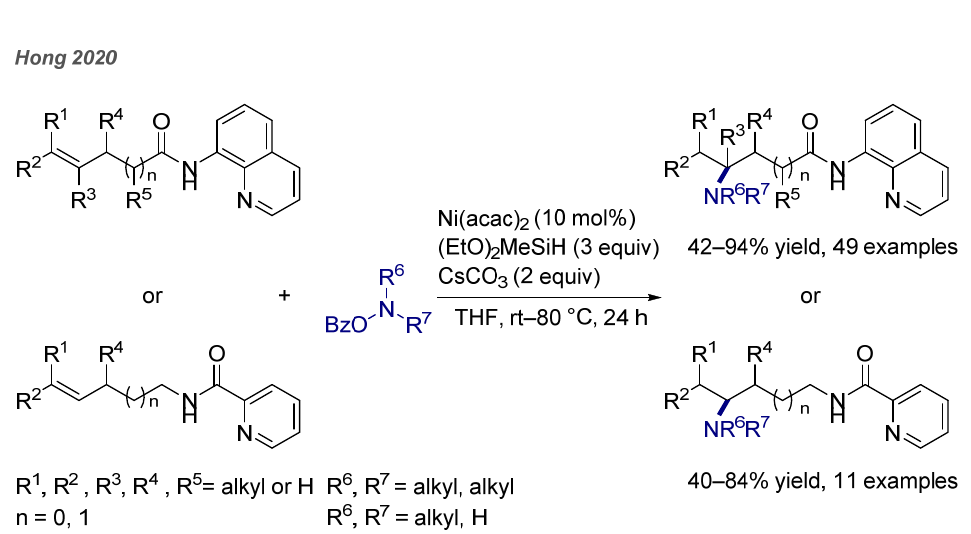
Figure 19. Regiocontrolled Ni-catalyzed hydroamination of alkenes tethered to amide linked aminoquinoline or to amine-derived picolinamides. rt = room temperature.